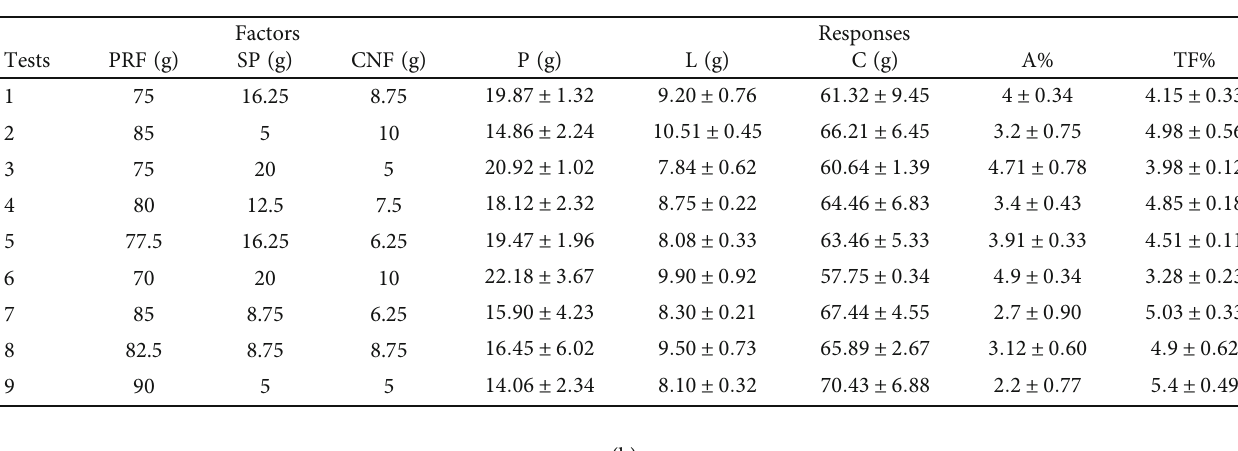
Table 2: Factors and response values of the 9 formulations.